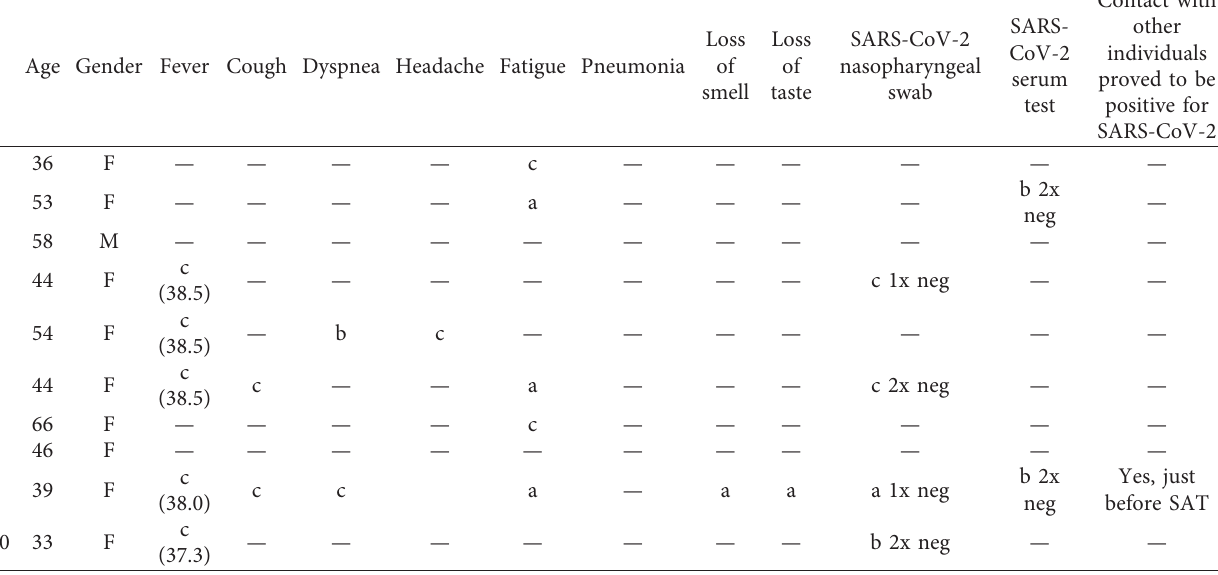
Table 1: Clinical symptoms and contact-tracing data of the included